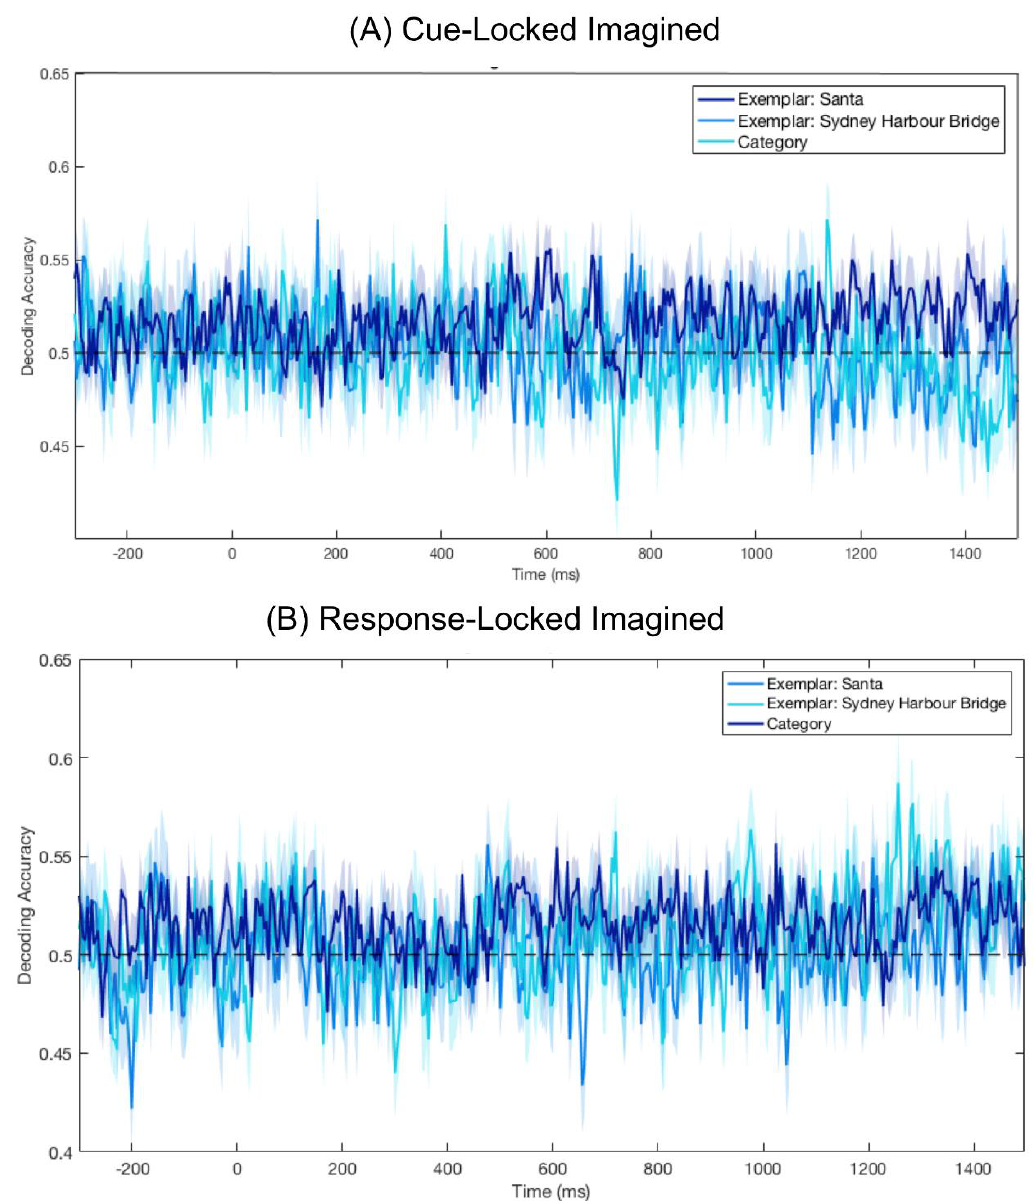
Figure 4. Mean decoding accuracy for Cue-Locked and Response-Locked Imagined epochs. The absence of dots below the plots indicates there were no points at which decoding was significantly above chance ( p s > 0.05). Shaded areas represent the standard error of the mean across subjects. ( A ) Decoding accuracy centred on presentation of the numerical cue indicating the location of the target in the preceding stream. ( B ) Decoding accuracy centred on when participants clicked to advance to the imagining period.